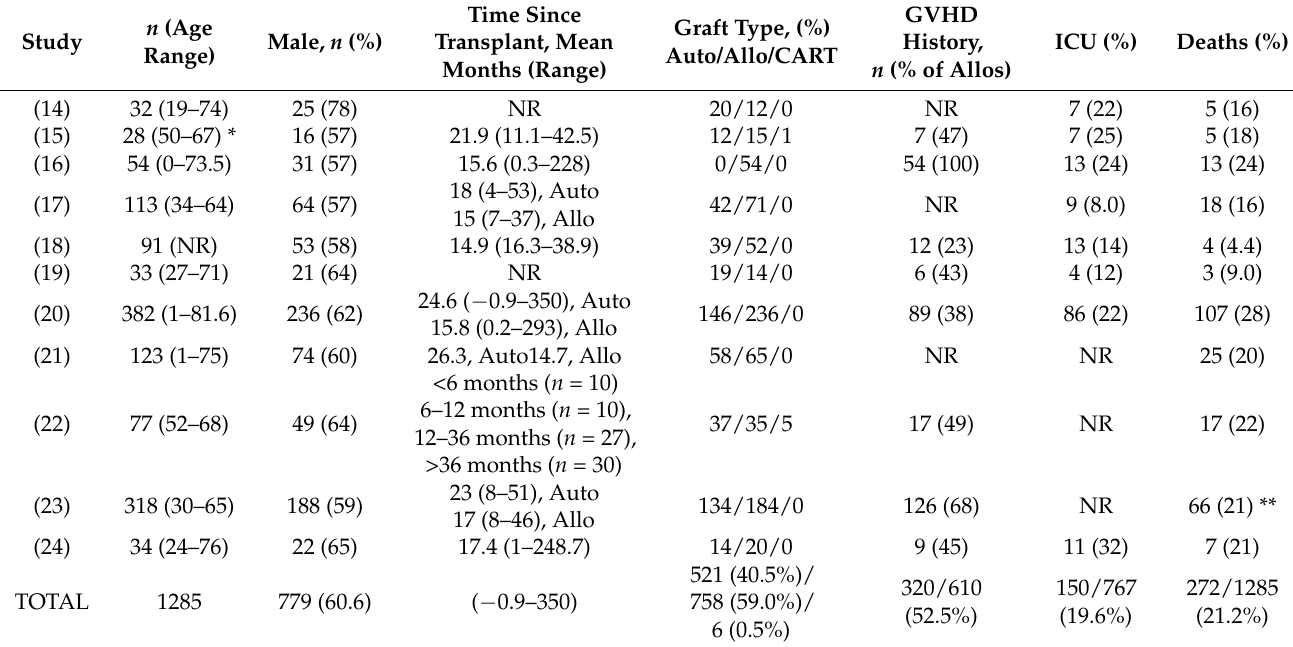
Table 1. Summary of the studies of adult patients with COVID-19 following HCT.